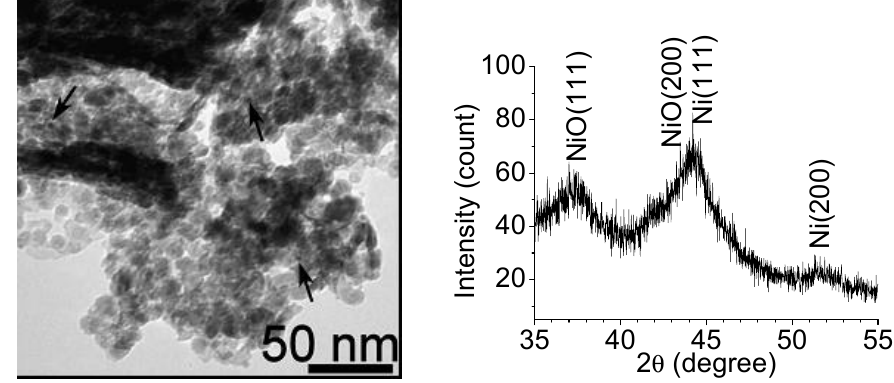
Figure 3. TEM and XRD pictures of self-prepared Ni/Al it can be seen that both Ni and NiO are found with average particle sizes of ~4 nm for both phases.